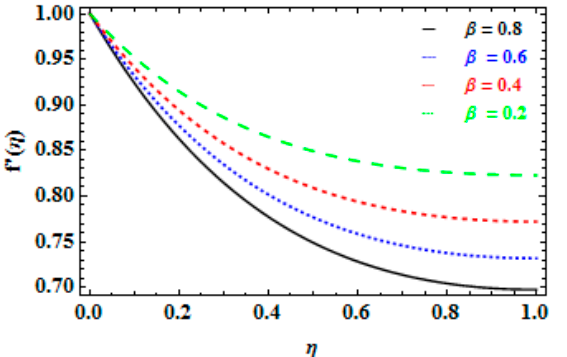
β on 𝑓 (cid:4593) ( 𝜂 ) .